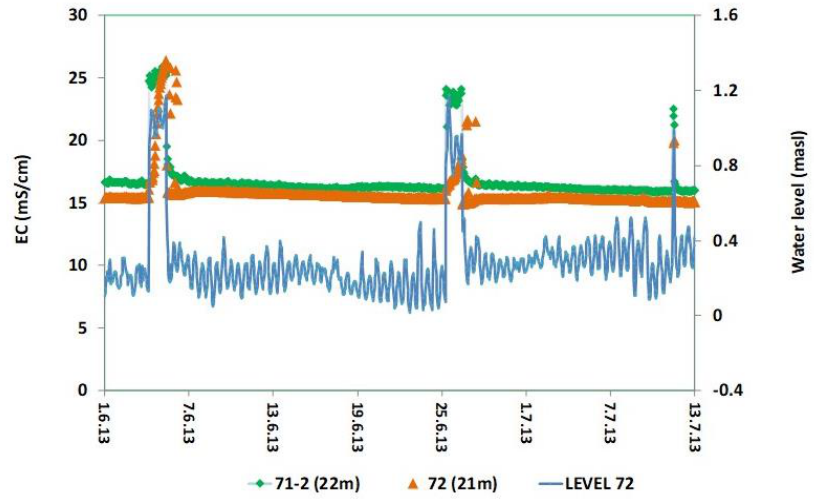
Figure 12. Changes in water level and EC due to pumping breaks obtained by CTDs in the observation wells 71-2 and 72 (distances of 50 and 75 m, respectively). The CTD were located at depth of 22 m (−19 masl) in well 71-2 and at depth 21 m (−20 masl) in well 72.